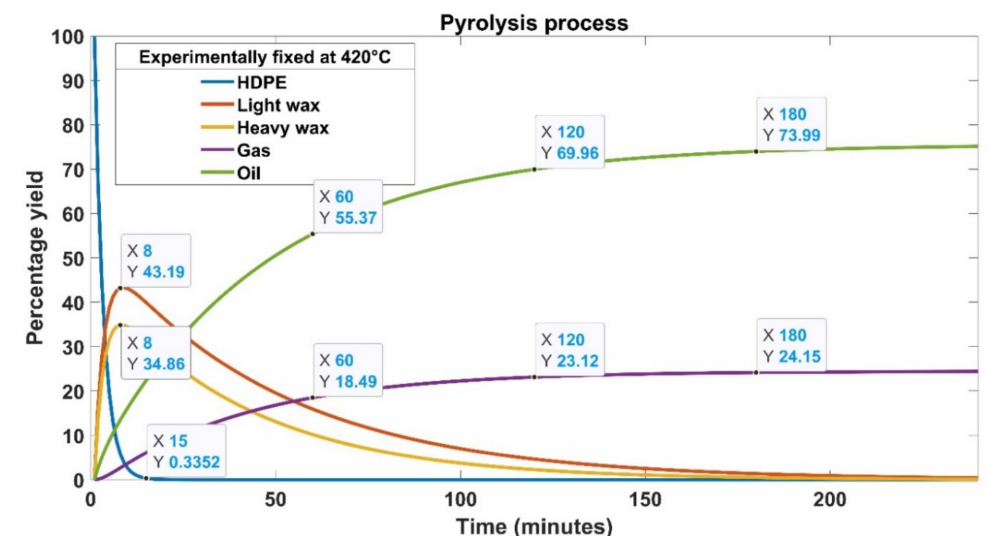
Figure 11. Graphical illustration of product type and yield for experimentally fixed rate constants at 420 ◦ C.